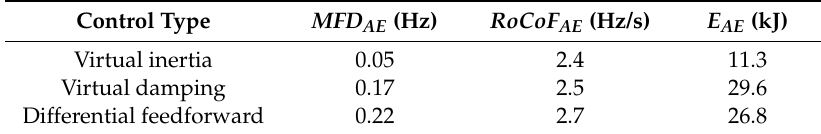
Table 3. Performance comparison among virtual inertia, virtual damping, and differential feedforward under load step.